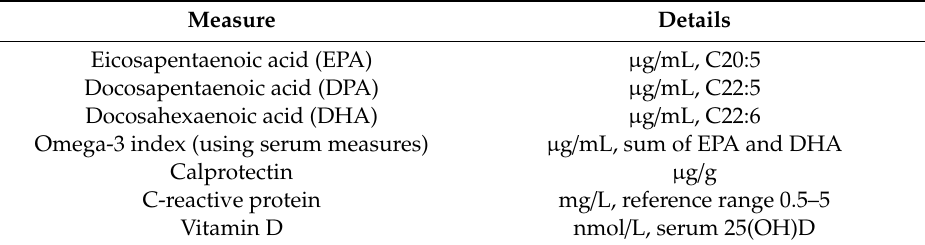
Table 1. Outcome measures: fatty acids, markers related to inflammation and vitamin